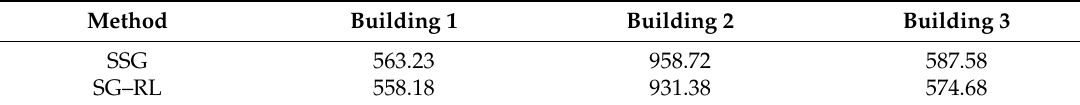
Table 4. Path length of SSG and SG–RL.